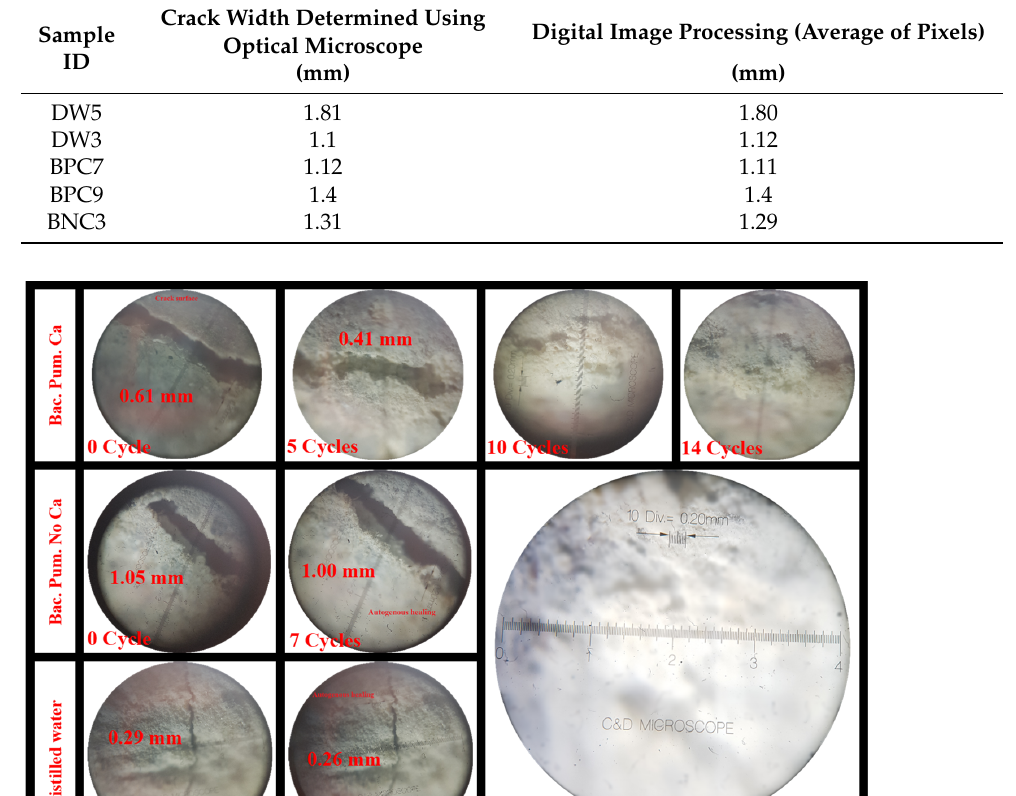
Table 5. Mortar crack widths determined using optical microscopy and image processing.